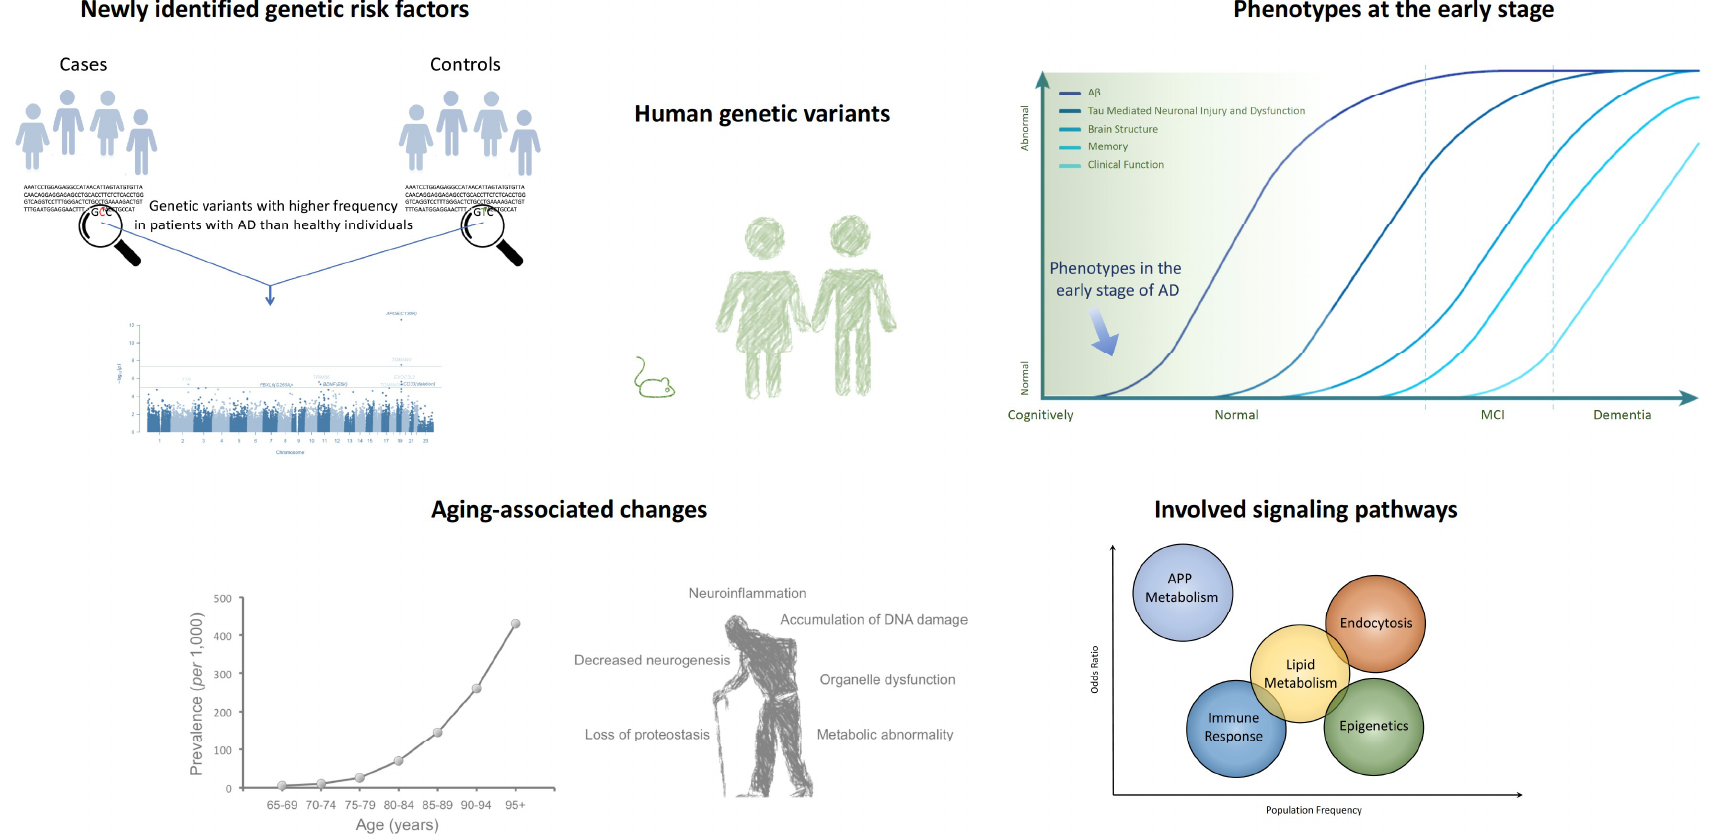
Figure 1. Genome-wide association studies (GWAS) have identified Alzheimer’s disease (AD)-associated genetic risk factors unique to humans, suggesting that cellular and molecular functional changes occur in the early stages of AD. Such studies have identified several signaling pathways that may be involved in AD, as well as the role of aging in pathological processes [21,41].